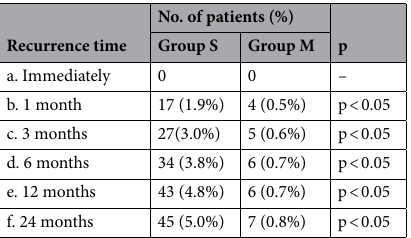
Table 2. Cumulative recurrence events after ablation.